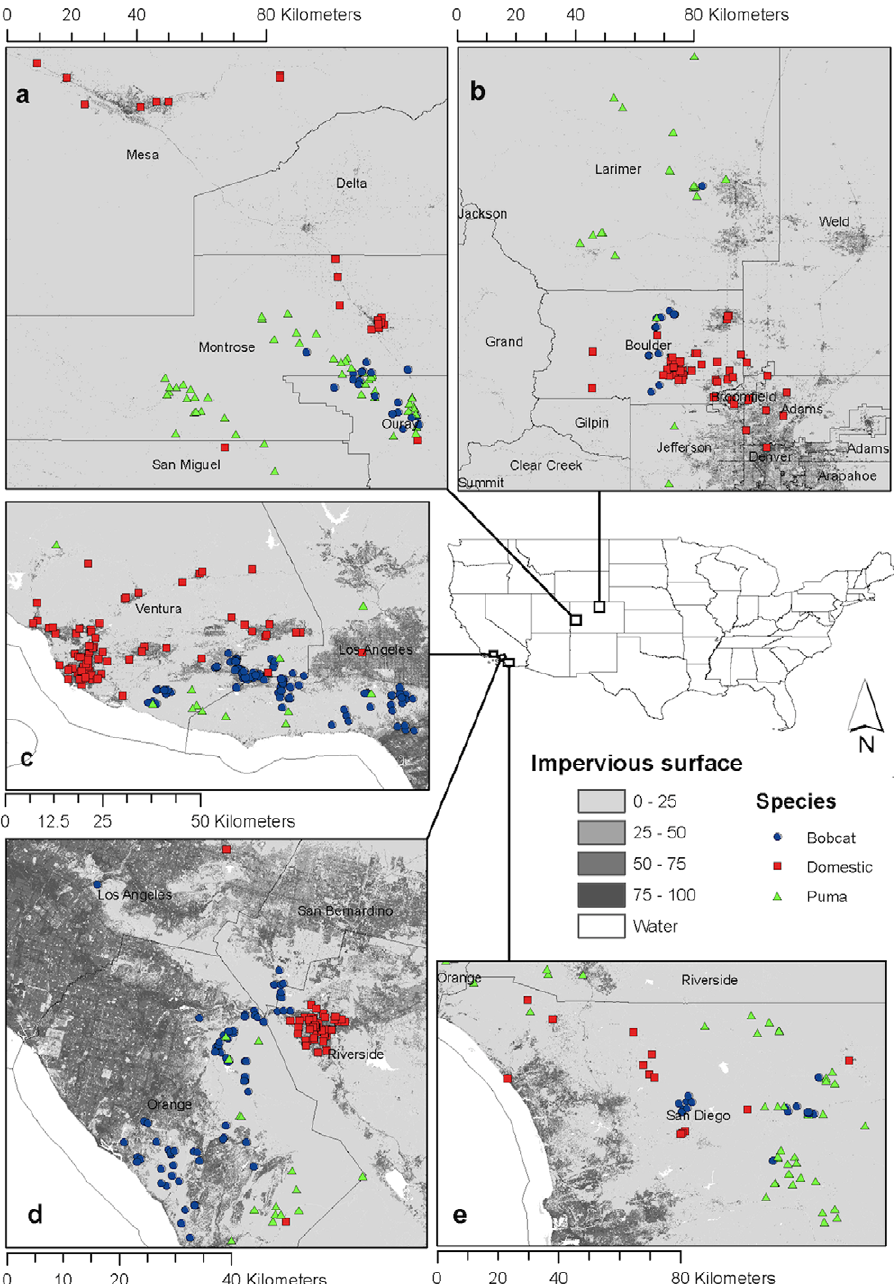
Figure 1. Capture locations of puma, bobcat, and domestic cat, in relation to urbanized areas, in the different study areas: (a) Colorado Western Slope, (b) Colorado Front Range, (c) Ventura County California, (d) Orange County California, and (e) Riverside/ San Diego Counties, California. Impervious surface refers to artificial materials found in urban areas (asphalt, concrete, etc.) and highly compacted soils and is an indicator of urban development intensity.